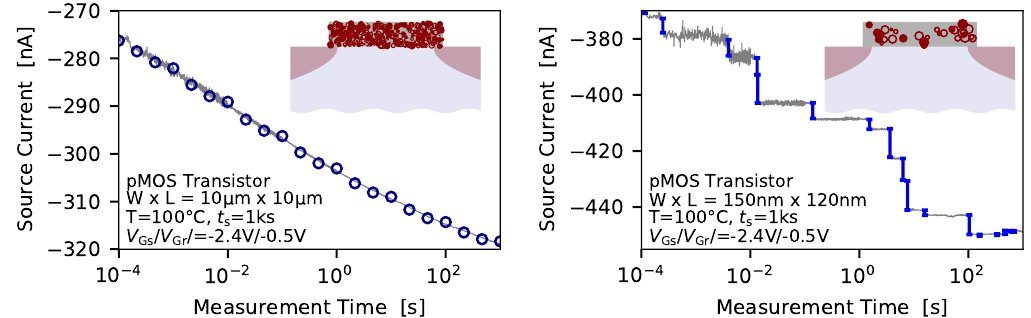
Figure 1. The main difference in the bias temperature instabilities (BTI) behavior of large-area and nanoscale devices is the number of defects contributing to the device behavior, and also the amplitude of impact of a single defect on the current flux through the device. ( left ) While in large-area devices a number of defects is responsible for a continuous drift of the drain-source current over time ( right ) the charge transitions of defects can be directly observed as discrete steps in the respective current signal recorded from nanoscale metal-oxide-semiconductor (MOS)